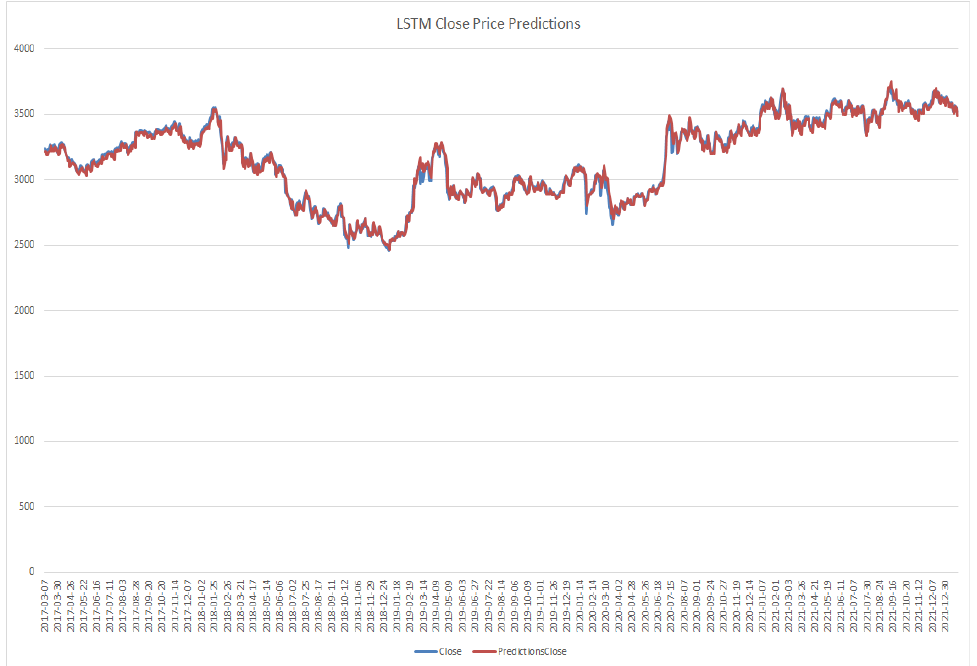
Figure 16. LSTM model close price prediction.